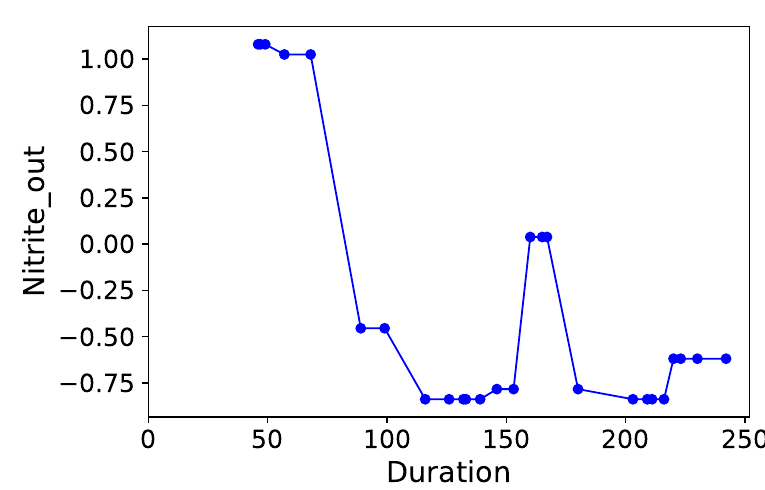
Figure A10. Normalized nitrite outlet flowrate for Reactor 1.